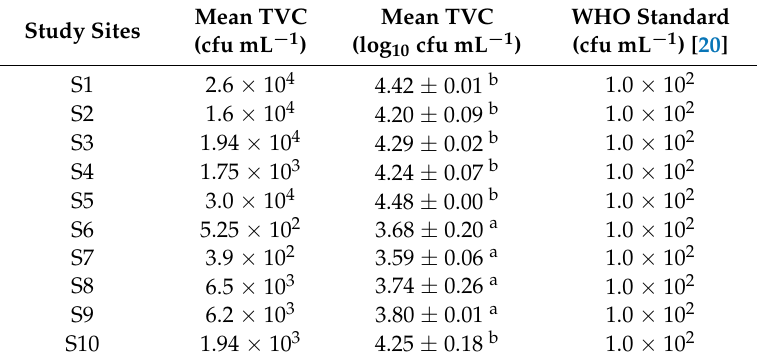
Table 1. Mean values of total bacteria count (cfu mL − 1 ) of 10 river stations in Bintulu, Sarawak,